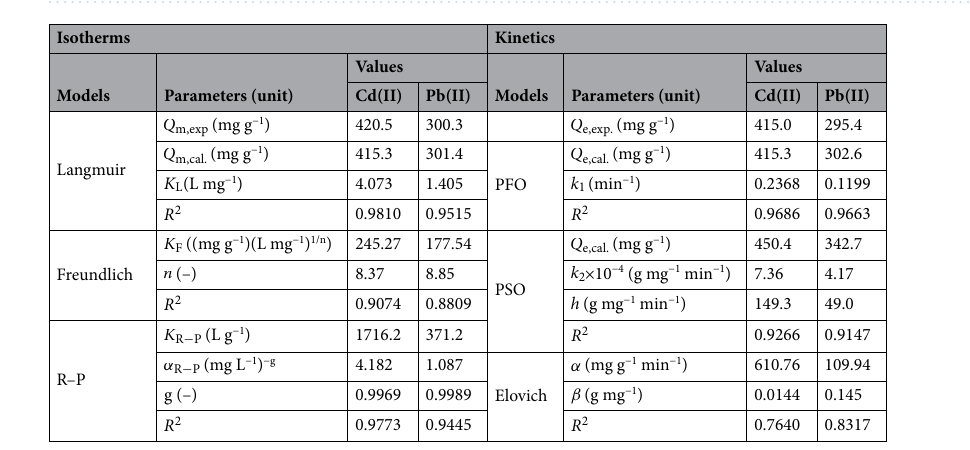
Figure 7. ( a ) The effect of equilibrium metal concentration on the adsorption capacity of Cd(II) and Pb(II) onto the LDH/MOF NC adsorbent and non-linear fitting of experimental data to different isotherm models, and ( b ) corresponding R L values (pH = 5.0, W =0.02 g, V = 20 mL, t = 120 min, T =25 °C, shacking speed = 200 rpm); ( c ) The effect of contact time on the adsorption capacity of Cd(II) and Pb(II) onto LDH/MOF NC adsorbent and non-linear fitting of experimental data to different kinetic models (pH = 5.0, W = 0.02 g, V = 20 mL, T = 25 °C, shacking speed = 200 rpm). C i = 100 mg L −1 ,